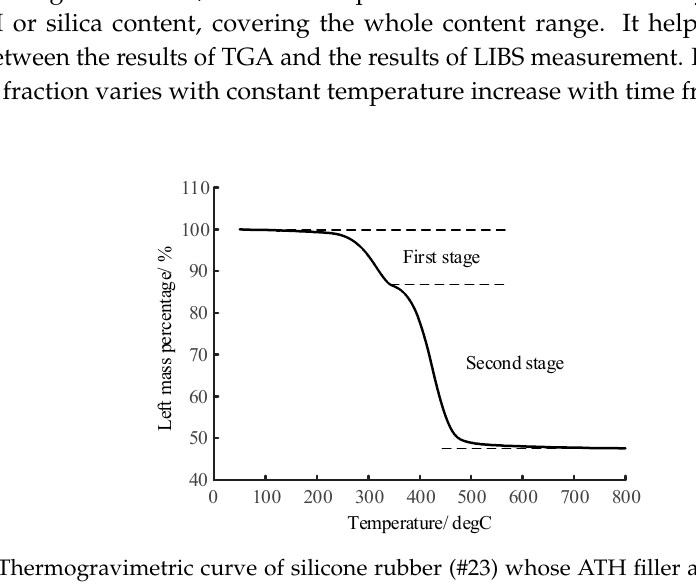
Figure 4. Thermogravimetric curve of silicone rubber (#23) whose ATH filler and silica filler mass fraction is 1.0 and 0.3, respectively, under a heating rate of 5 °C/K.